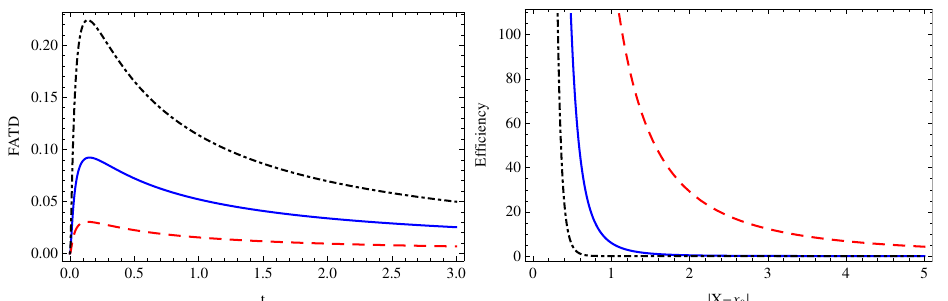
Figure 9. Left panel: FATD (68) for D x = 1, D y = 1, v = 0, and X − x 0 = 2 (blue solid line), v = 1 and X − x 0 = − 2 (red dashed line), and v = 1 and X − x 0 = 2 (black dot-dashed line). Right panel: Efficiency (70) for D x = 1, D y = 1, and v = 0 (blue solid line), v = 10 and X > x 0 (red dashed line), and v = 10 and X < x 0 (black dot-dashed